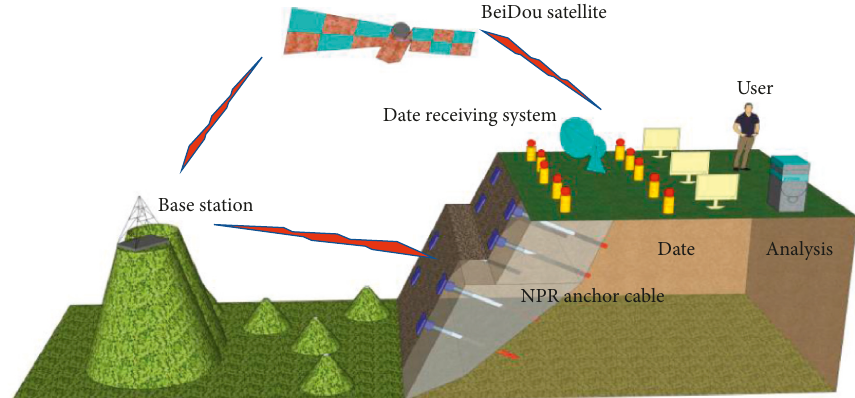
Figure 11: Data transmission